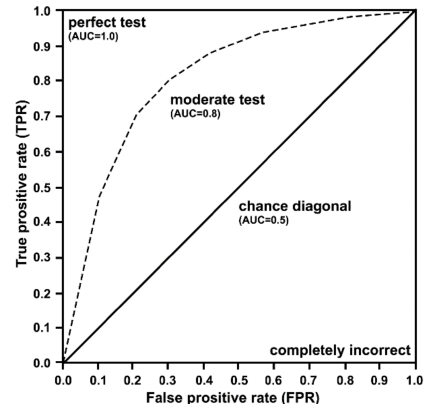
Figure 5. Receiver operating characteristic (ROC) curves with respective area under the curve (AUC) evaluating hypothetical data.